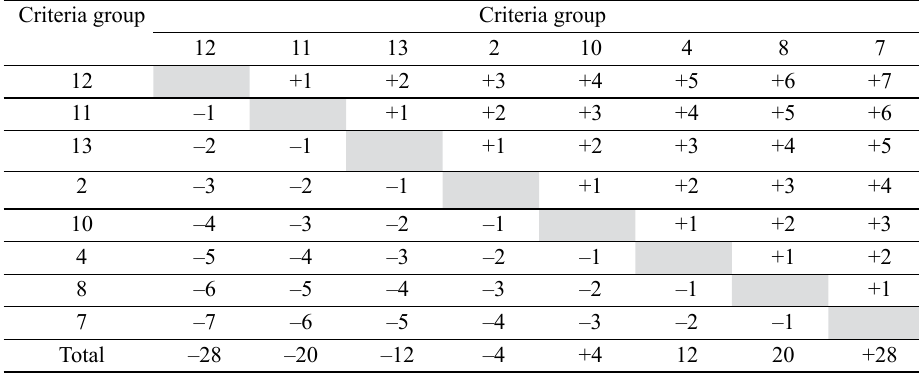
Table 7. A summary matrix of the potential equilibrium of the criteria